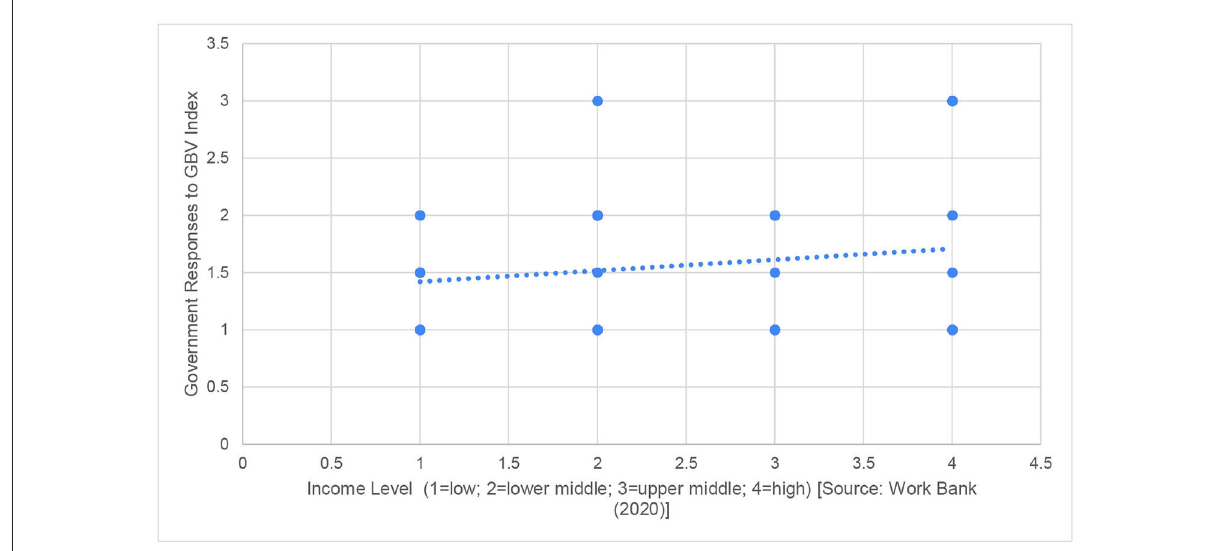
FIGURE2 Comparing income level to government responses to GBV during COVID-19.